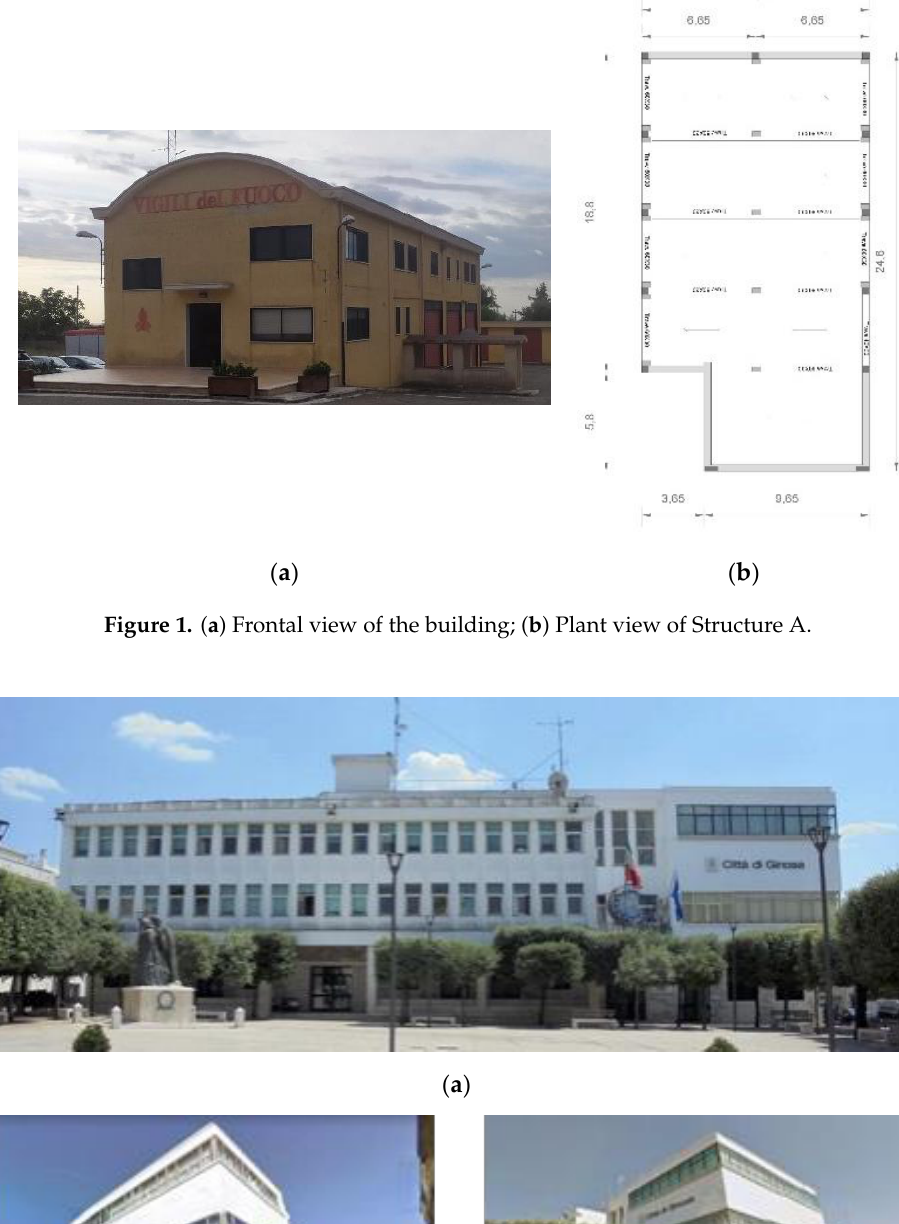
Figure 3. Plant type view of Structure B. 3. Environmental Vibration Testing The vibration measurement tests were carried out to characterize the modal properties of both buildings. Regarding the monitoring system: the chain of acquisition was composed of high sensitivity seismic accelerometers ICP PCB 393B31 (sensitivity = 10 V/g) monoaxial piezometric type, with a frequency range from 0.1 to 200 Hertz, a multi-channel acquisition system (National Instruments (NI)—NI 9230), with three simultaneously sampled analog inputs with a ±30 V input range, and a platform NI Compact DAQ DSA with eight slots. In each one, it is possible to integrate a NI 9234 chassis able to acquire simultaneously from the channels. The accelerometers enable us to obtain accelerometers data for low frequency and low acceleration values. They have been installed through a threaded pin on a cubic-shaped metal element in order to ensure the orthogonality of the couple of accelerometers placed on the same position. The cubic support element is then fixed to the